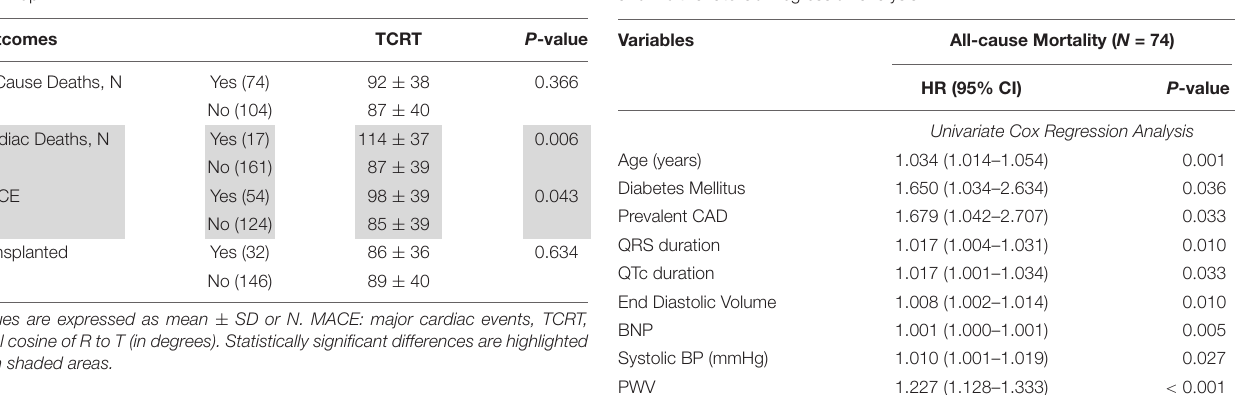
TABLE 3 | Variables associated with increased all-cause mortality by univariate and multivariate Cox regression